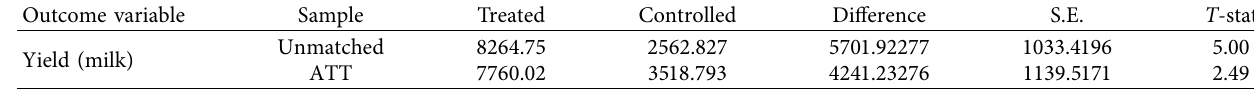
Table 9: Estimation of ATT for milk yield (lit/annum).